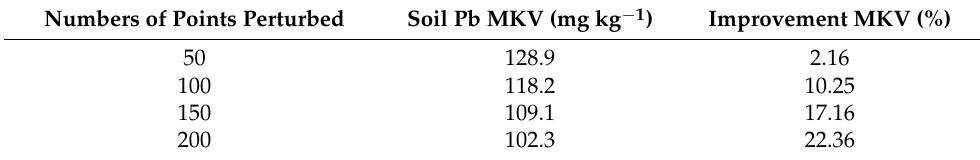
Table 6. The improvement MKV after the initial sampling design was perturbed by SSA. Numbers of Points Perturbed